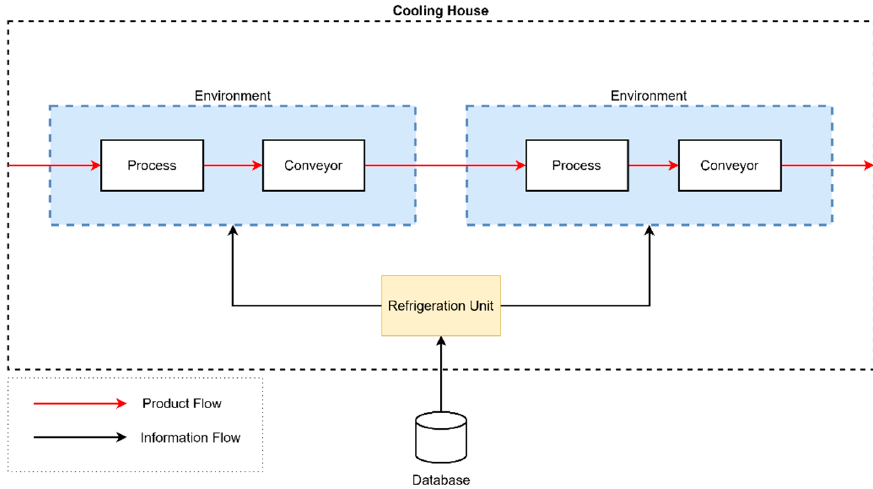
Figure 1. The simulation architecture.